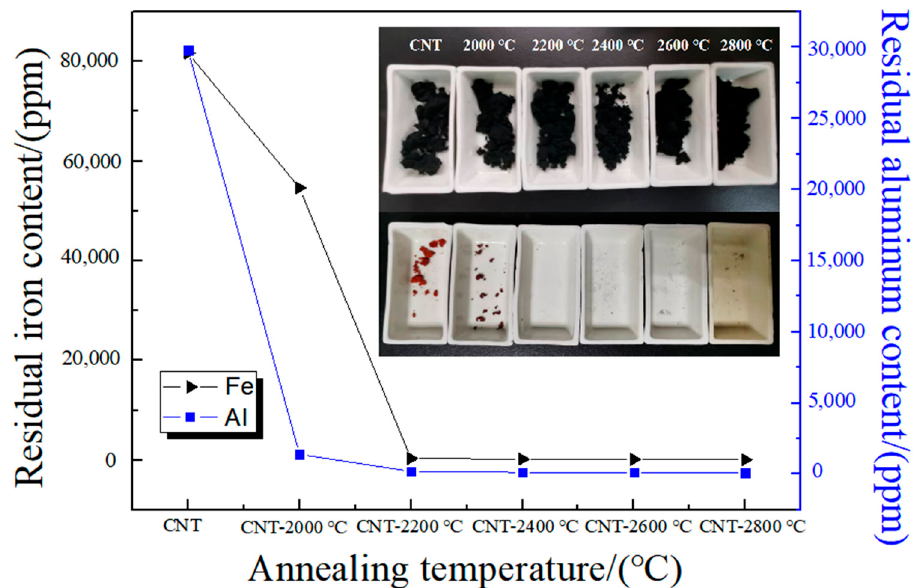
Figure 1. ICP of MWNTs annealed at different temperature for 180 min, the inset shows MWNTs with different annealing temperatures before and after air firing at 800 °C.